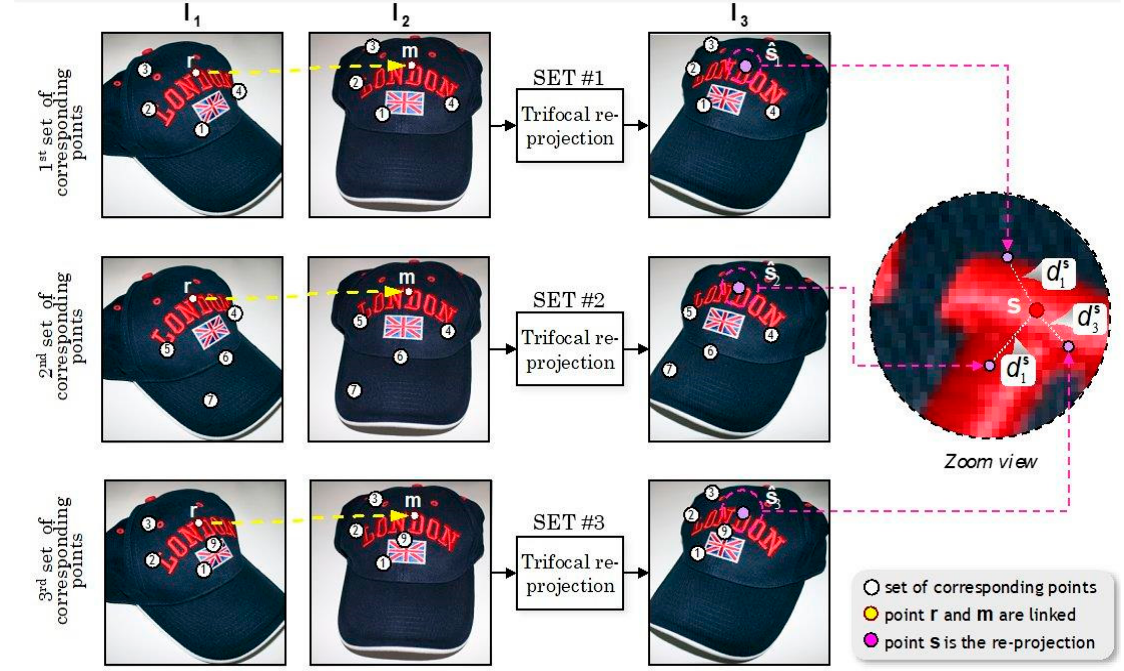
Figure 6. Point-correspondence and detection of wrong matches using the multiple geometric correspondence (MGC) filter.